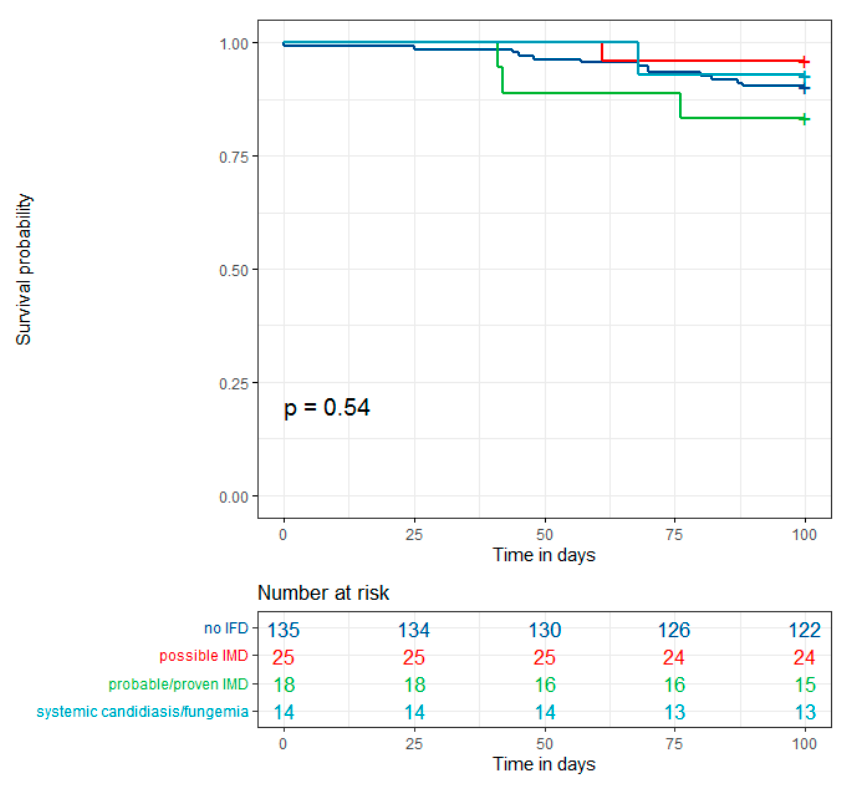
Figure 3. Kaplan–Meier 100-day survival curves according to IFD 2020